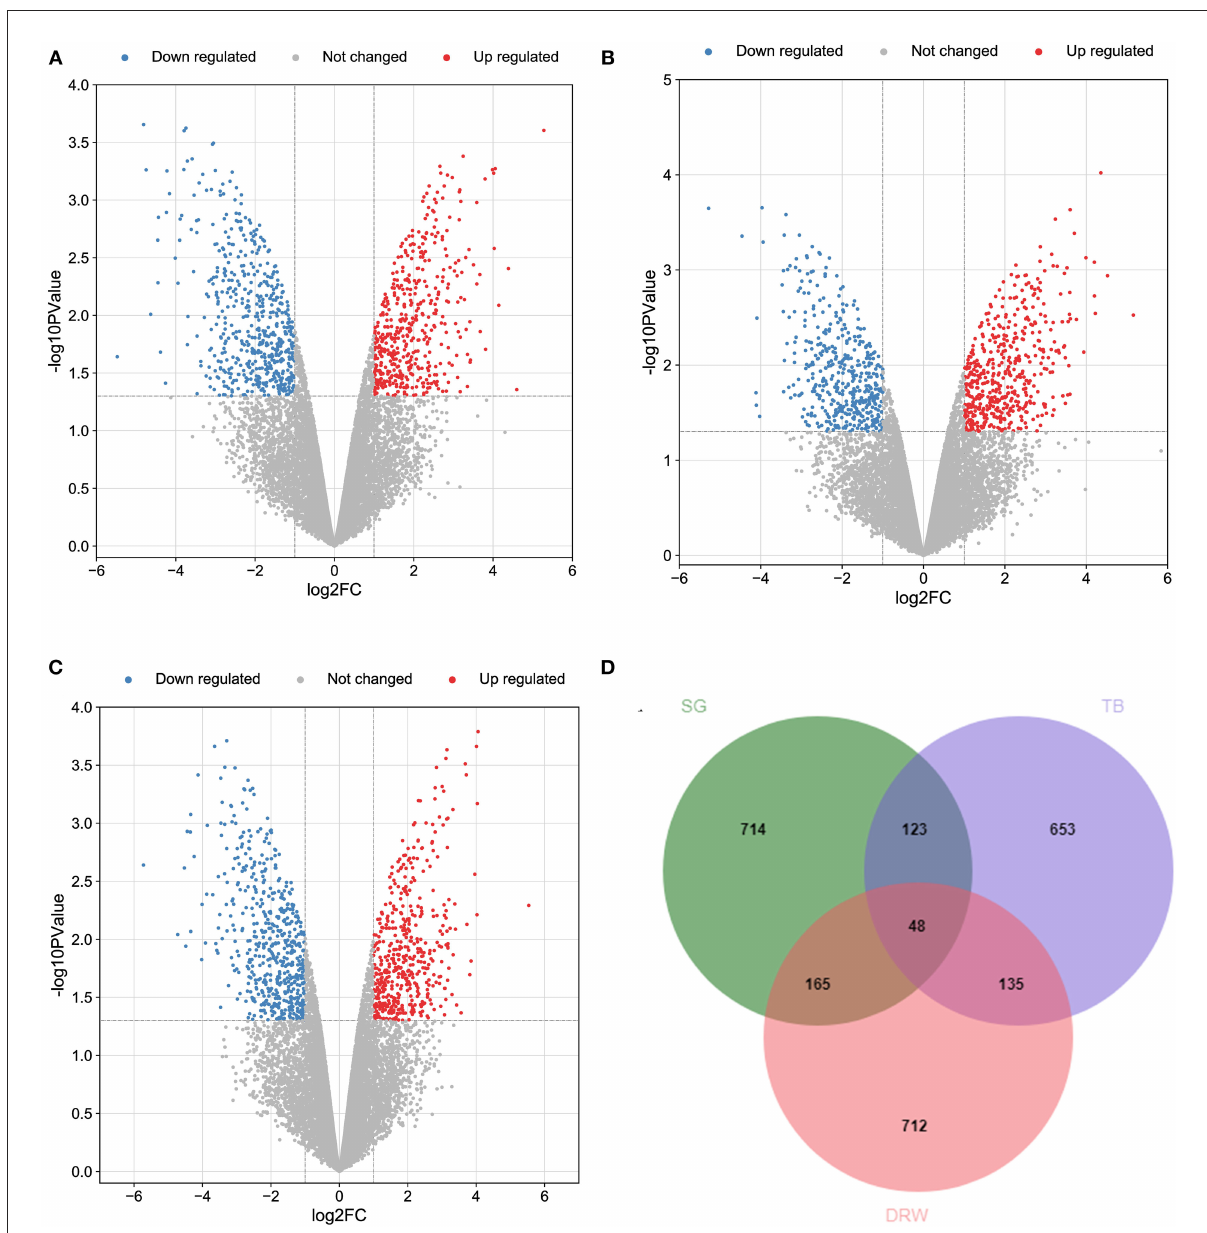
FIGURE1 The profile of transcripts and genes in the hearts of chickens treated with hypoxia and normoxia. (A–C) revealed the volcano plot of the DEGs in the hearts of SG, TB, and DRW chickens treated with hypoxia and normoxia. The red and blue points represent the upregulated and downregulated genes. The gray spots mean unchanged genes. (D) indicated the Venn diagram for the DEGs mentioned